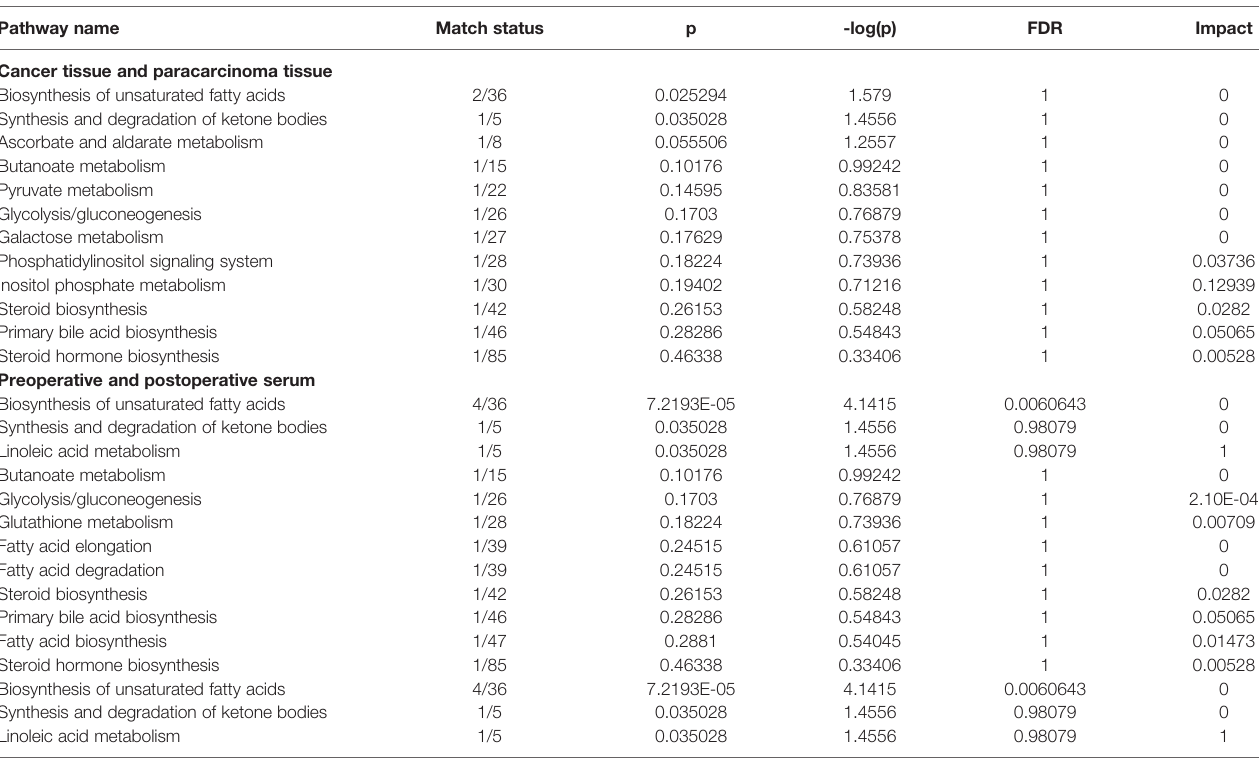
TABLE 3 | Result from ingenuity pathway analysis with MetaboAnalyst